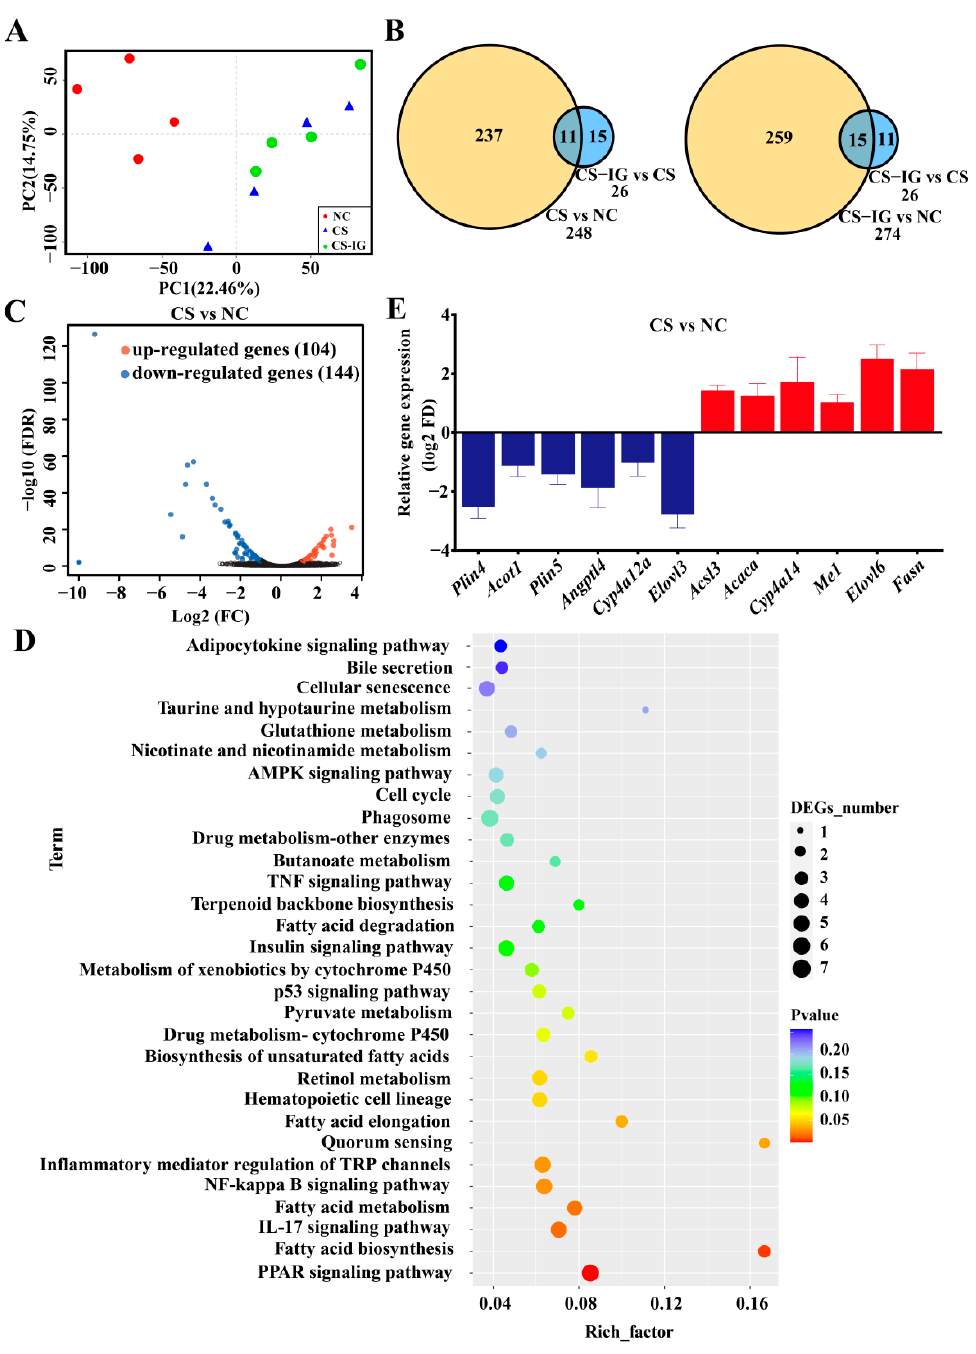
Figure 6. Effects of cigarette smoke exposure on the liver transcriptome of mice. ( A ) Principal component analysis (PCA). ( B ) Differentially expressed genes (DEGs) detected among NC, CS, and CS-IG groups. ( C ) Volcano diagram of DEGs. ( D ) KEGG enrichment pathway analysis. ( E ) DEGs involved in the lipid metabolism pathway. Data were expressed as means ± SEM ( n = 4). NC, mice treated with normal air exposure; CS, mice treated with cigarette smoke exposure; CS-IG, mice treated with combination of cigarette smoke exposure and intragastric administration of nicotine-degrading strain JQ581.